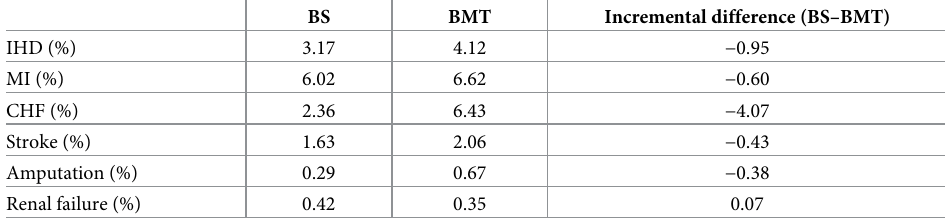
Table 7. Incidence of diabetes-related complications.